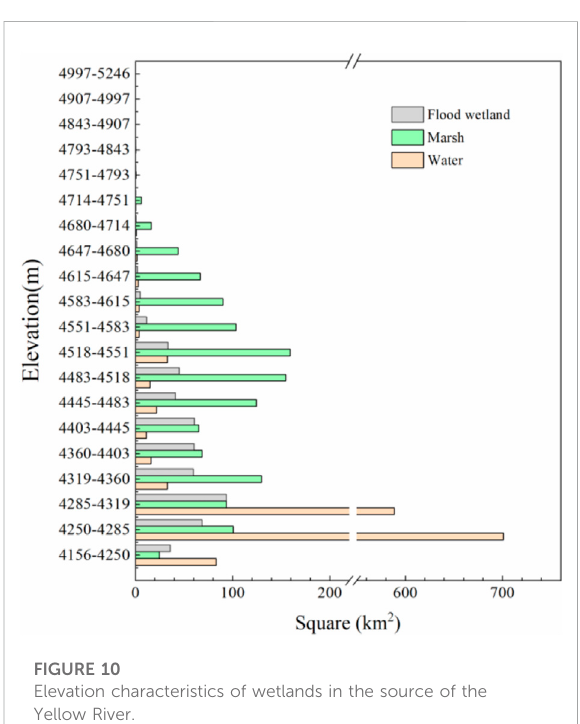
Elevation characteristics of wetlands in the source of the Yellow River.